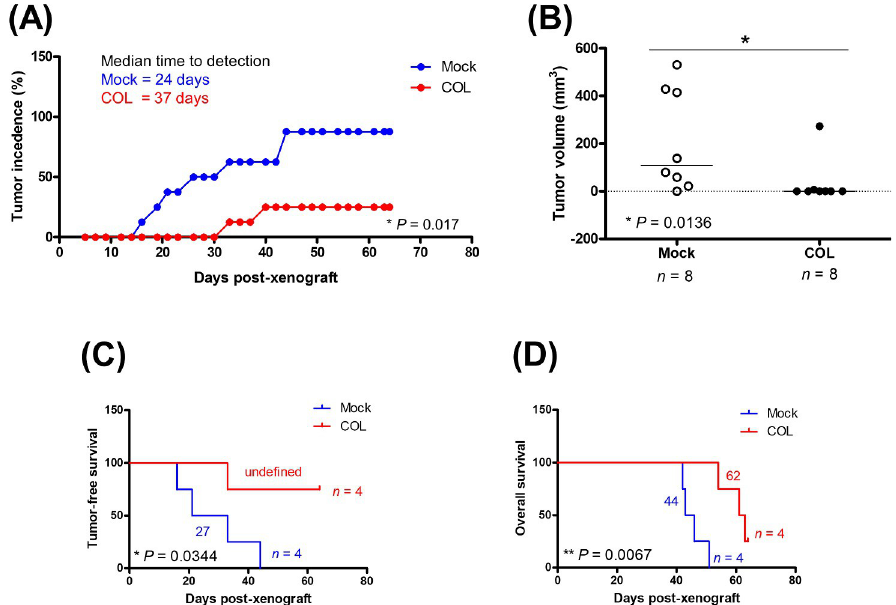
Fig 6. COL17 delays breast cancer progression and prolongs survival in mice. The stable MDA-MB-231/COL17 (COL) and mock cells were treated with 0.1 μ g/ml of doxycycline (Dox) for 48 hours before implanting into mammary fat pads of the mice (2 sites per mouse, 4 mice per group). The COL17 expression was induced by treating the mice with 1mg/ml Dox in drinking water. (A) The number of palpable tumors was displayed as a percentage of 8 implantation sites in mock (blue) and COL group (red). Median time-to-tumor detection in each group is presented. The difference of tumor incidences between COL and mock groups was analyzed by the two-tailed Student’s t -test. (B) The maximum volume of tumors measured at the end of study in mice grafted with mock or COL cell. Tumor-free survival (C) and overall survival (D) of xenograft mice were observed until the end of study (9-week post-xenograft). Log-rank test was used for survival analysis. Student’s t -test with Welch’s correction was used for boxplot. � P < 0.05, �� P < 0.01.